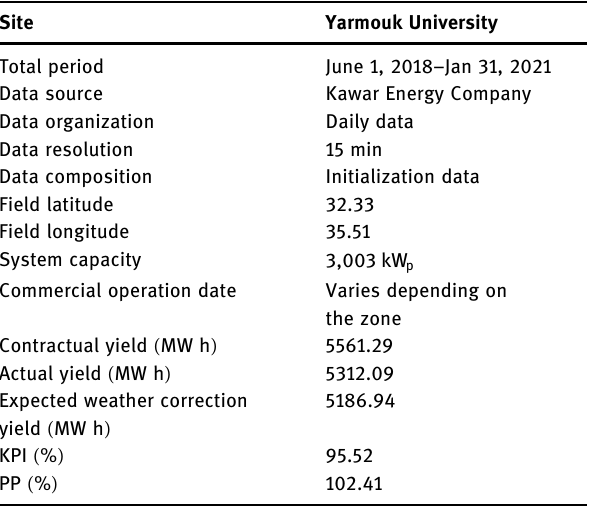
Table 3: Monthly estimated energy ( MW h ) for Yarmouk